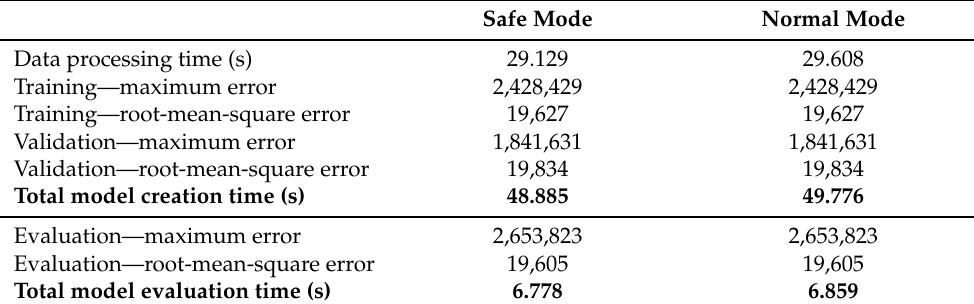
Table 4. Comparison of the averaged measurement results of the ‘SteamReviewsCleaned’ dataset for the safe and normal boot mode.